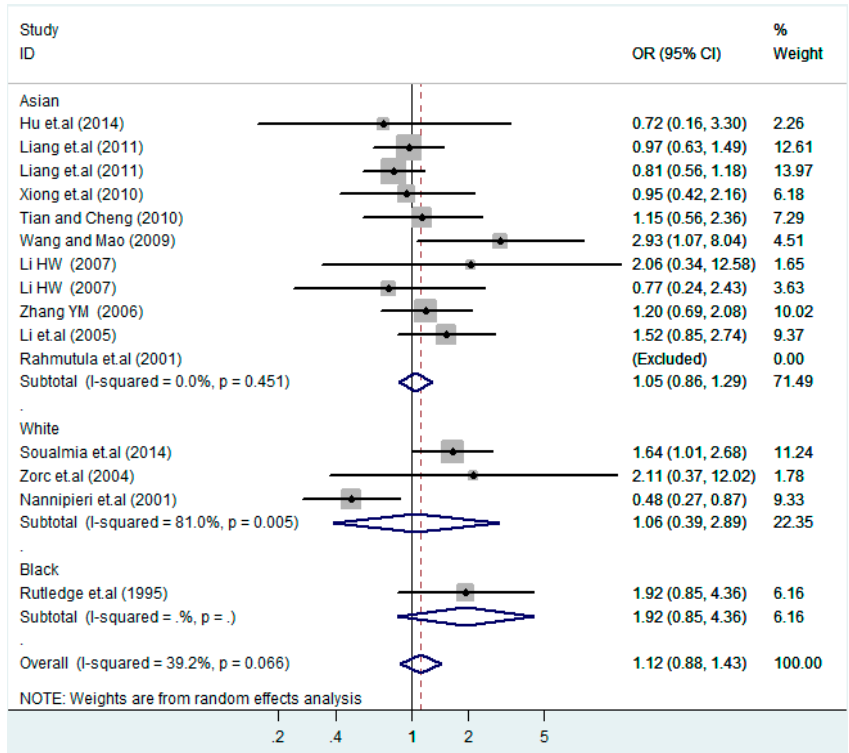
Figure 11. Ethnic subgroups analysis of T2238C co-dominant model-2 (CC vs. TT). Int. J. Environ. Res. Public Health 2016 , 13 , 458